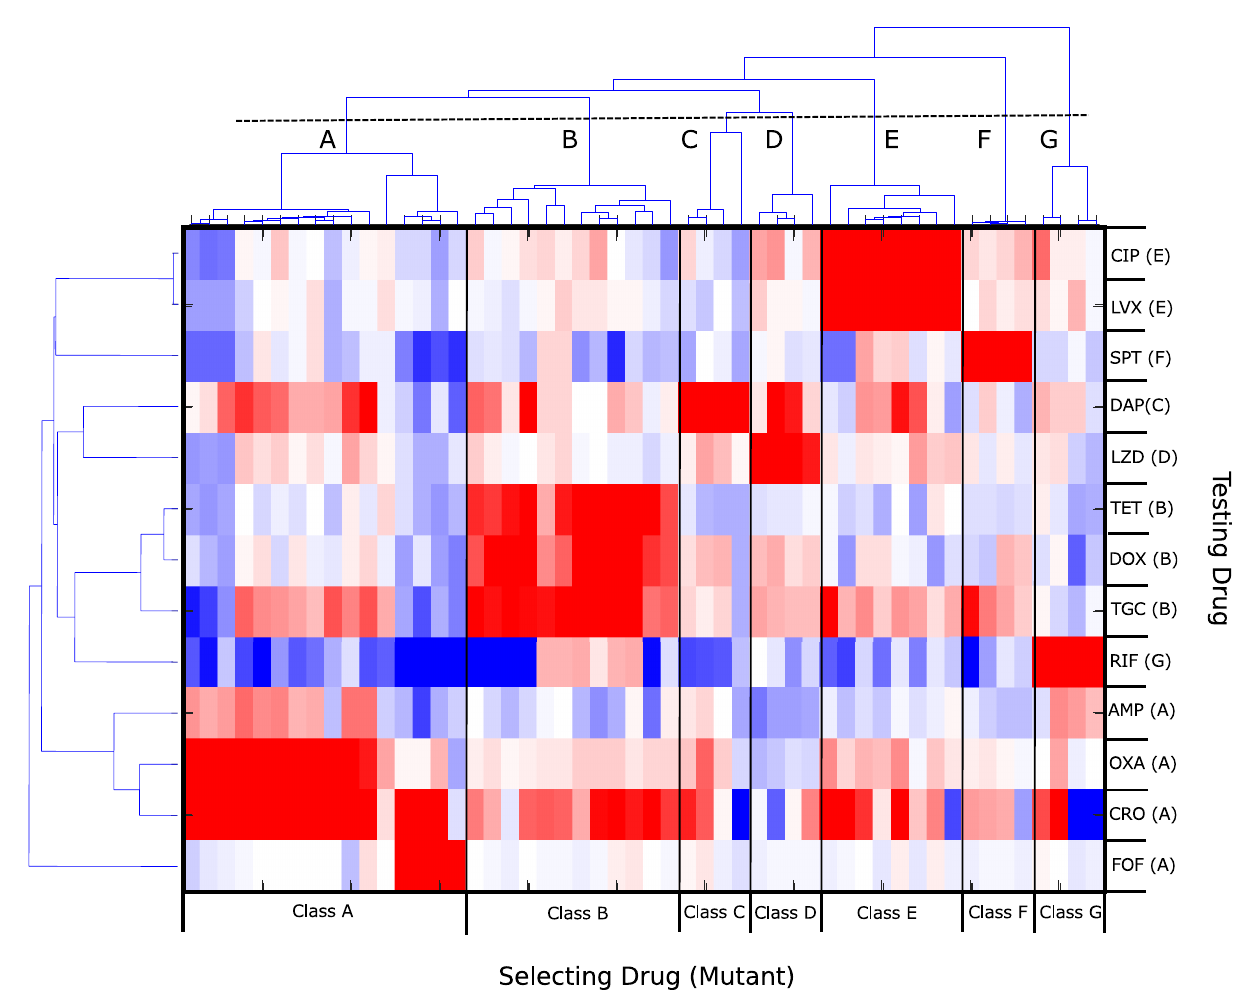
Fig 4. Hierarchical clustering of collateral sensitivity profiles partitions mutants into groups selected by known drug classes. Heat map with ordering of rows (testing drug) and columns (four replicate experiments with the same selecting drug) determined via hierarchical clustering. Colormap and scale are identical to those used in Fig 1. Collateral profiles (columns) for mutants selected by drugs from known drug classes (here labeled A–G) cluster together; if clusters are defined using the dashed line (top), there are seven distinct clusters, each corresponding to a particular drug class: (A) cell wall synthesis inhibitors (AMP, OXA, CRO, FOF), (B) tetracyclines (TET, DOX, TGC), (C) lipopeptides (DAP), (D) oxazolidinones (LZD), (E) fluoroquinolones (CIP, LVX), (F) aminocyclitols (SPT), and (G) antimycobacterials (RIF). When clustering the testing drugs (rows), drugs from the same class are frequently but not always clustered together. For example, cell wall drugs such as AMP, OXA, and CRO form a distinct cluster that does not include FOF (bottom four rows). See also S1 Table. AMP, ampicillin; CIP, ciprofloxacin; CRO, ceftriaxone; DAP, daptomycin; DOX, doxycycline; FOF, fosfomycin; LVX, levofloxacin; LZD, linezolid; OXA, oxacillin; RIF, rifampicin; SPT, spectinomycin; TET, tetracycline; TGC, tigecycline.